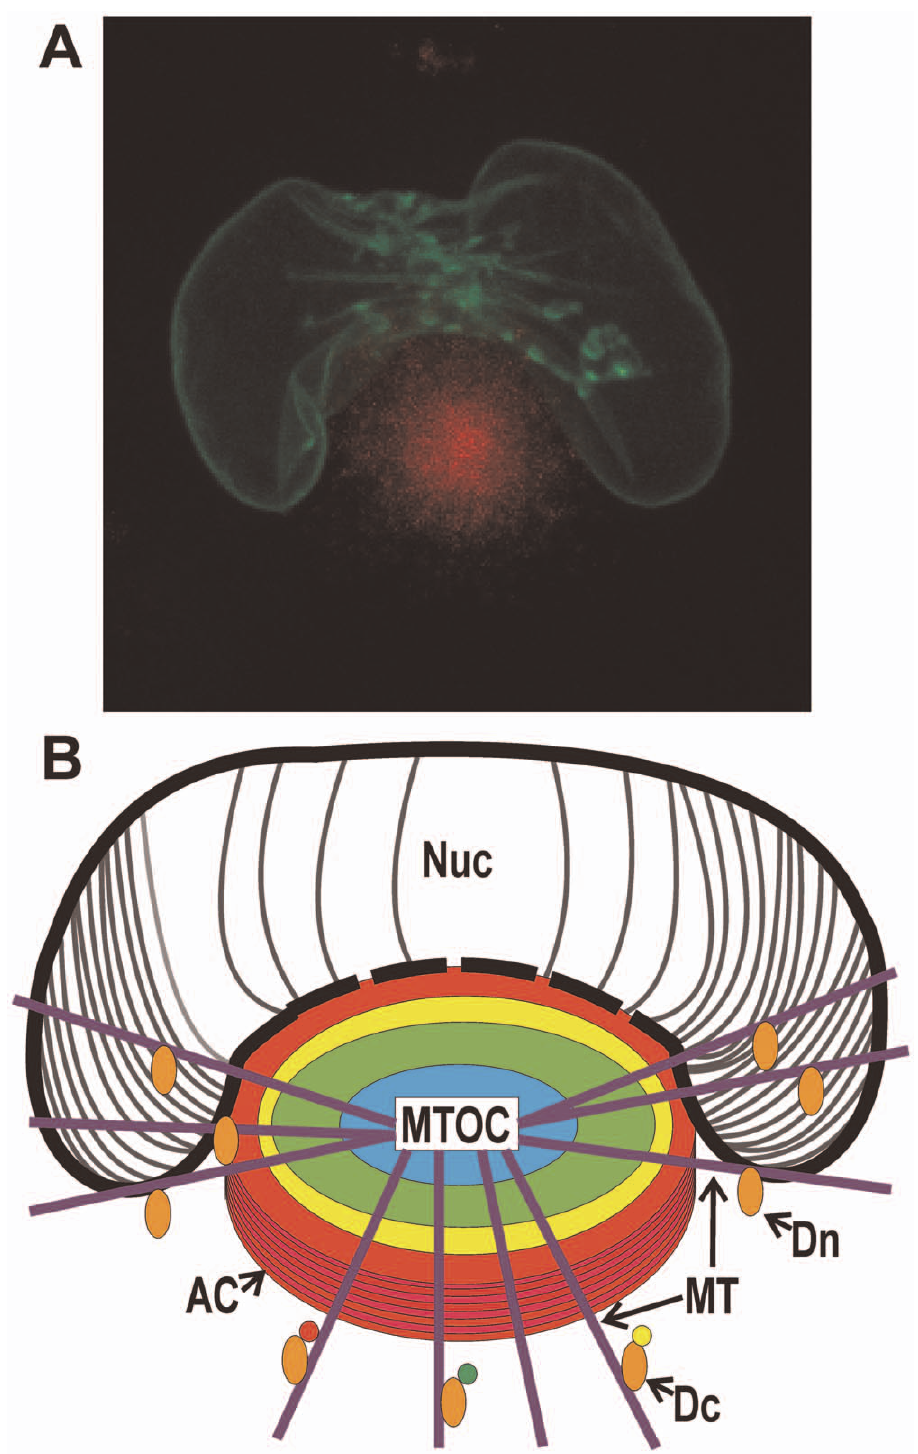
Figure 1. Microscopic and diagrammatic representations of the assembly compartment and nucleus in an HCMV-infected cell. (A) Maximum projection live cell micrograph showing the AC (identified by Dsred-tagged pp28, red) with the enlarged, kidney-shaped nucleus (identified by GFP-tagged lamin A) wrapped around the AC. (B) A poor artist’s diagrammatic representation of the AC located next to the enlarged, kidney-shaped nucleus. The AC is formed on a microtubule organizing center (MTOC) with microtubules (MT) radiating from it. The nested cylindrical makeup of the AC is indicated by colored circles; each cylindrical region is proposed to be made up of vesicles derived from specific secretory organelles. Virion tegument and structural proteins reside with these vesicles and are applied to nucleocapsids as they egress from the nucleus and traverse toward the center of the AC. The point of contact between the AC and the nucleus may be a continuum, suggested by the dashed line representing the nuclear membrane at this junction. This may allow nucleocapsids open access from the nucleus to the AC late in infection. The AC and the kidney-shaped nucleus are formed by virally commandeered functions of dynein. Dynein (Dn) is shown pulling the nucleus around the AC by a mechanism similar to mitotic nuclear envelope breakdown. Dynein loaded with cargo (Dc) is shown to represent the formation of the